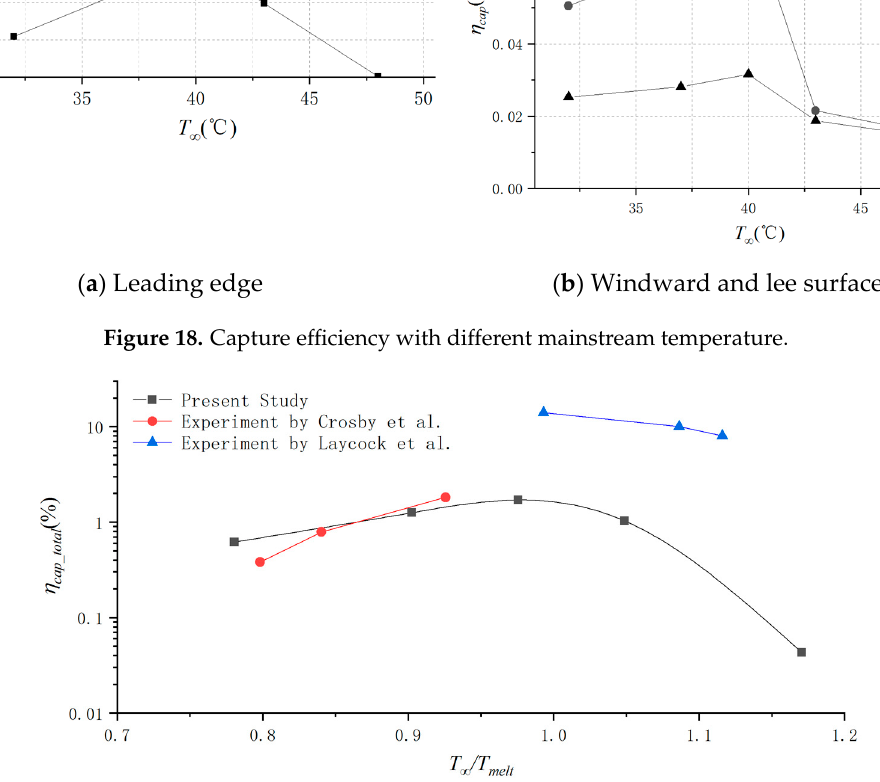
Figure 19. Total capture efficiency herein compared to data from Crosby [11] and Laycock [17].